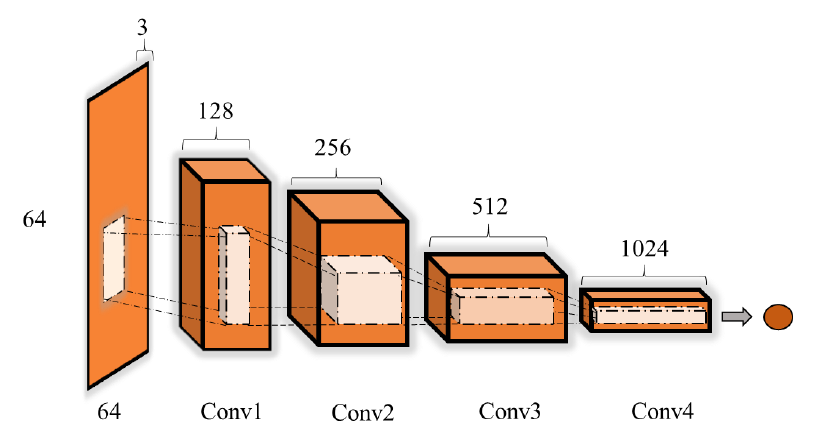
Figure 9. The structure of the discriminator. Table 3. Detailed architecture for the discriminator.